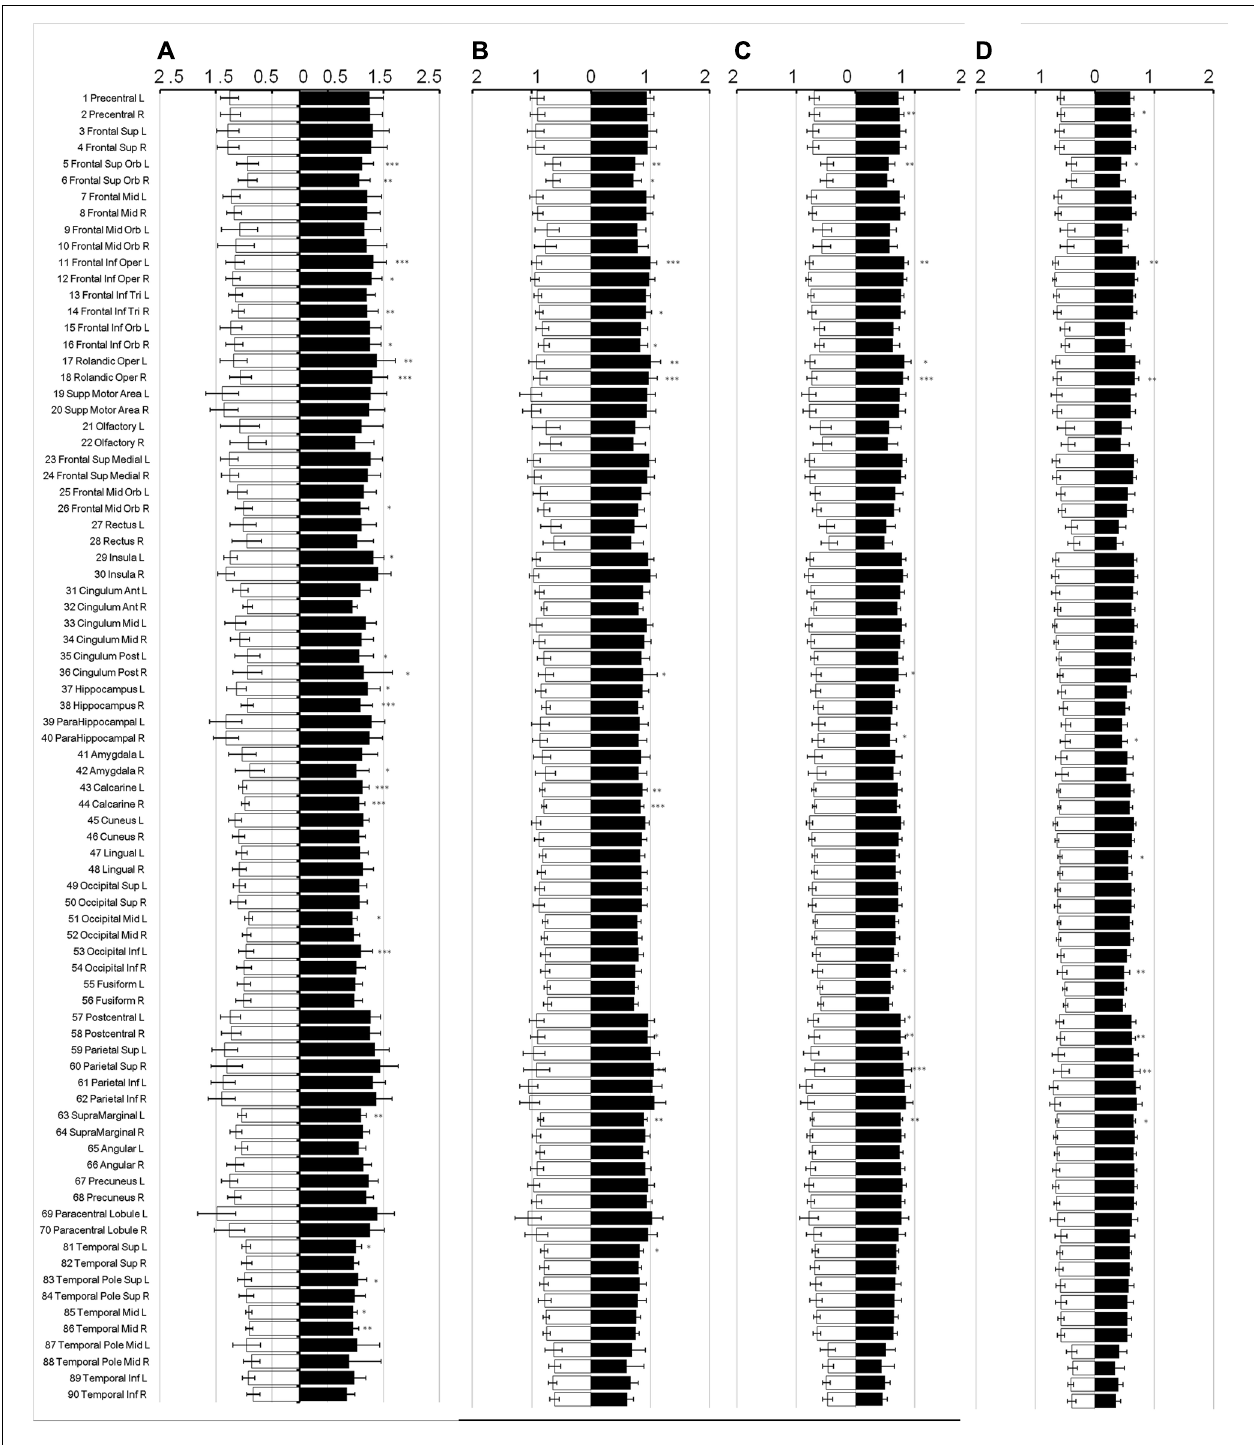
FIGURE 3 | Mean diffusivity from different diffusion weights. The figure shows the mean diffusivity calculated between a non-diffusion- weighted image and images with different diffusion weights from 1,000 (A) , 2,000 (B) , 3,000 (C) , and 4,000 (D) s/mm 2 . The mean